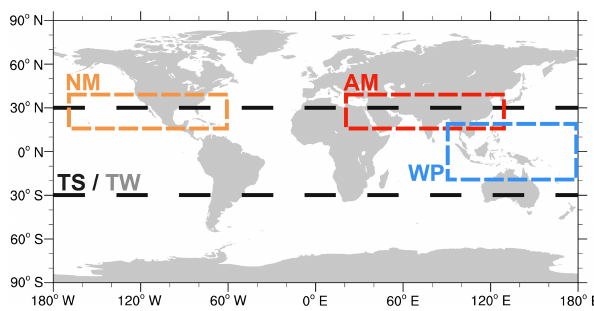
Figure 1. Definition of the source regions used for the initialization of mass and water vapour tracers. According to the tagging region and period, the tracers are named as follows: AM (Asian summer monsoon, 15–40 ◦ N × 20–130 ◦ E, red dashed), NM (North Amer- ican monsoon, 15–40 ◦ N × 170–60 ◦ W, orange dashed), TS/TW (tropics NH summer/winter, 30 ◦ S–30 ◦ N, black dashed) and WP (warm pool, 20 ◦ S–20 ◦ N × 90–180 ◦ E, blue dashed). For the size, tagging period and tagging height of the tracer regions, see Table